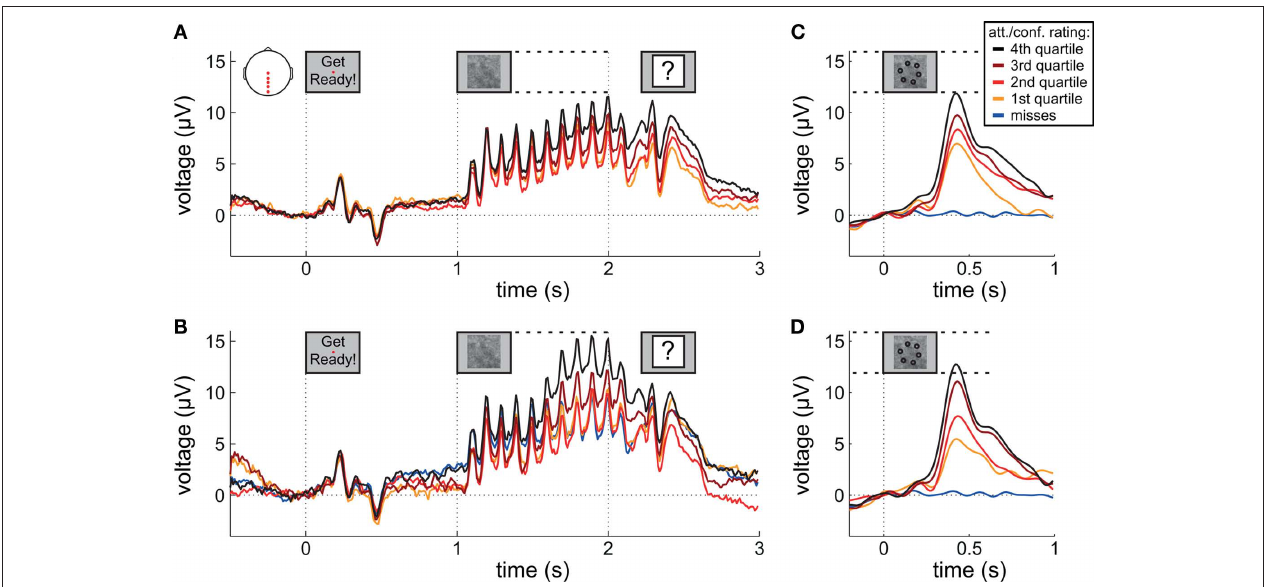
Figure 3 | event-related potentials during preparation and stimulus presentation. (A,B) Grand average ERPs time-locked to the onset of the